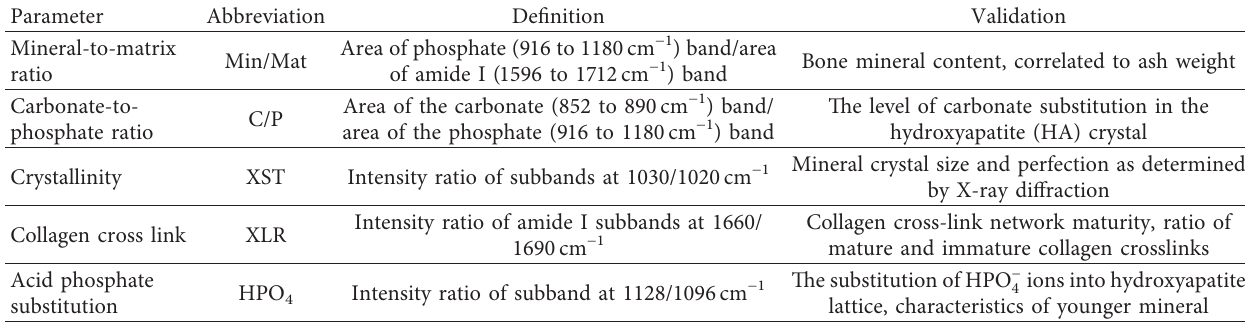
Table 1: Summary of FTIR parameters.